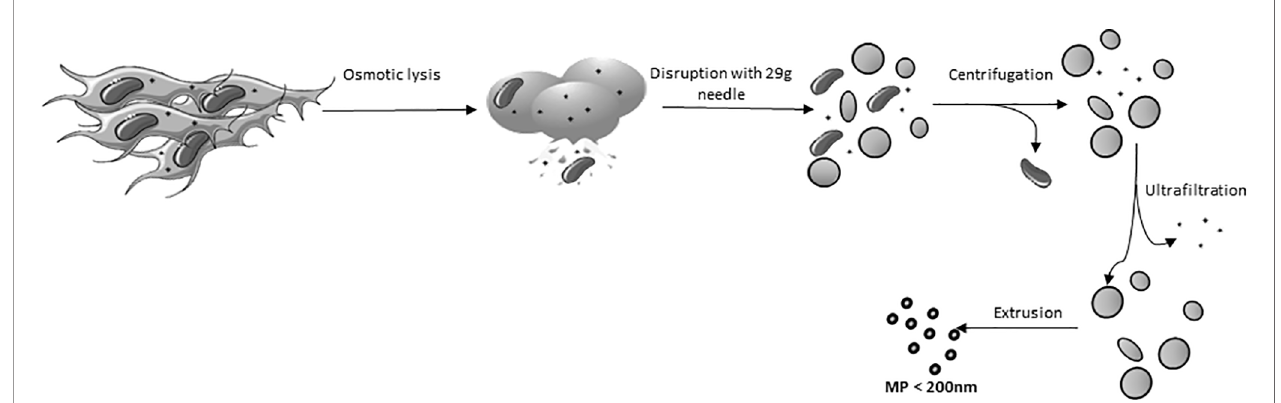
FIGURE 1 | Schematic overview of the generation of Membrane